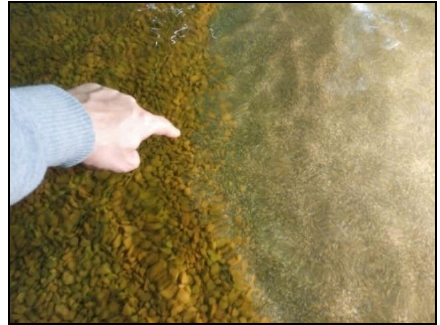
Figure 5. Transportation of a number of sediment particles out of the studied sand-bed reach.